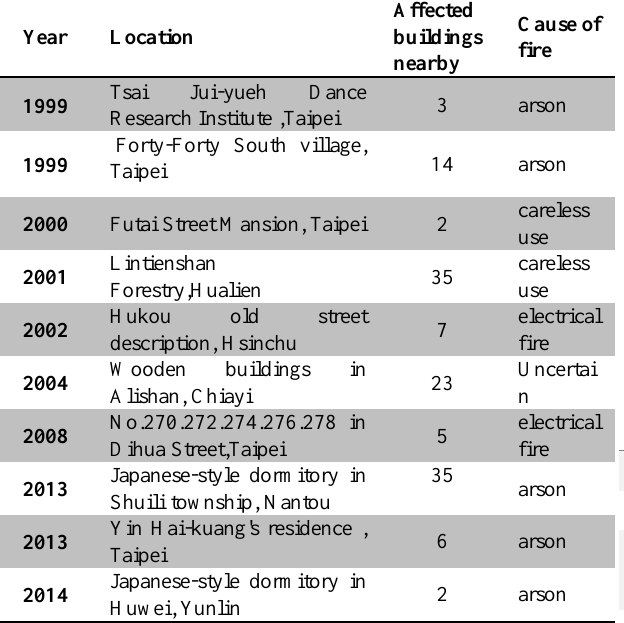
Table1. The events of the fire spread in Taiwan